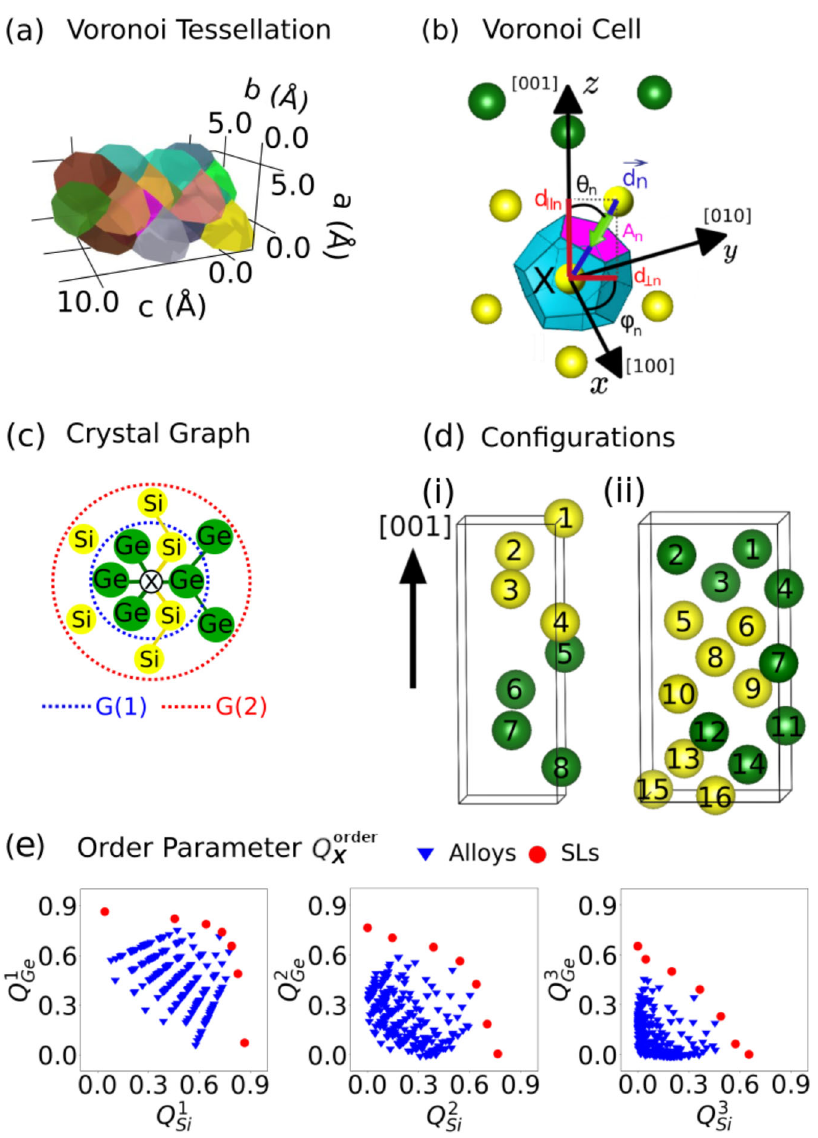
Fig. 2 Formulation of features using Voronoi tessellations. a Voronoi tessellations of a model Si 4 Ge 4 SL. b Voronoi cell of atom X in a SiGe model heterostructure. c Representative crystal graphs connecting atom at node X with order = 1 ( G (1) (blue)) and 2 ( G (2) (red)) neighbors. d Selected con fi gurations to illustrate order parameter concept: (i) Si 4 Ge 4 SL, (ii) Si 8 Ge 8 disordered “ alloy ” . e Order parameters of relaxed ordered and disordered training